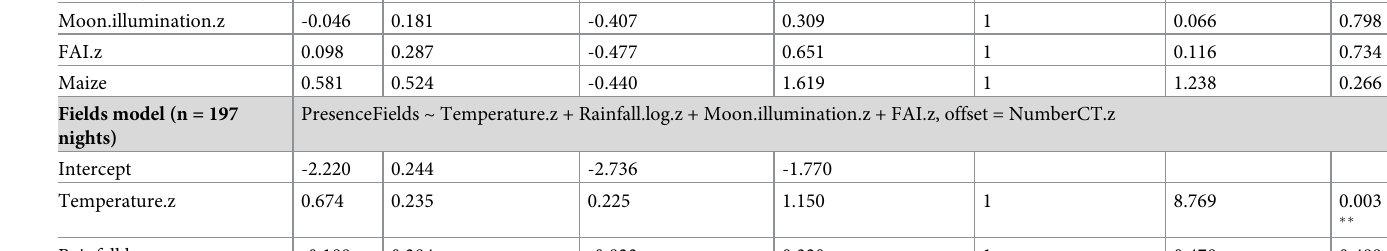
Lower confidence Higher confidence Degree of freedom Statistics value p (sd) limit limit (df) ( χ 2 )